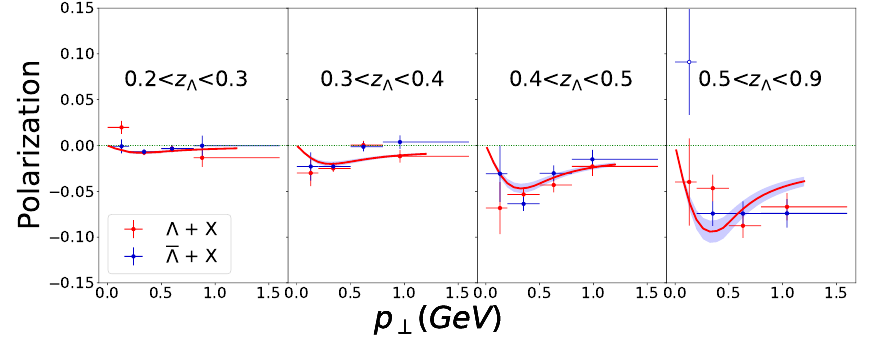
¯Λ single-inclusive polarization against Belle Figure 9 . Comparison of our fit estimates for the Λ / data, adopting the double parametrization for the Power-Law